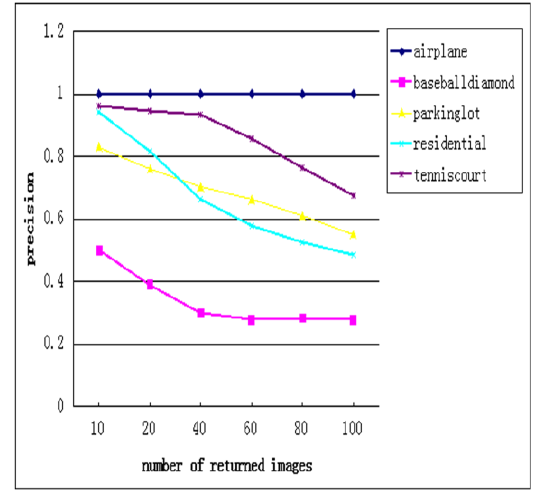
Figure4. Retrieval results of five class images using combined features with different numbers of returned images